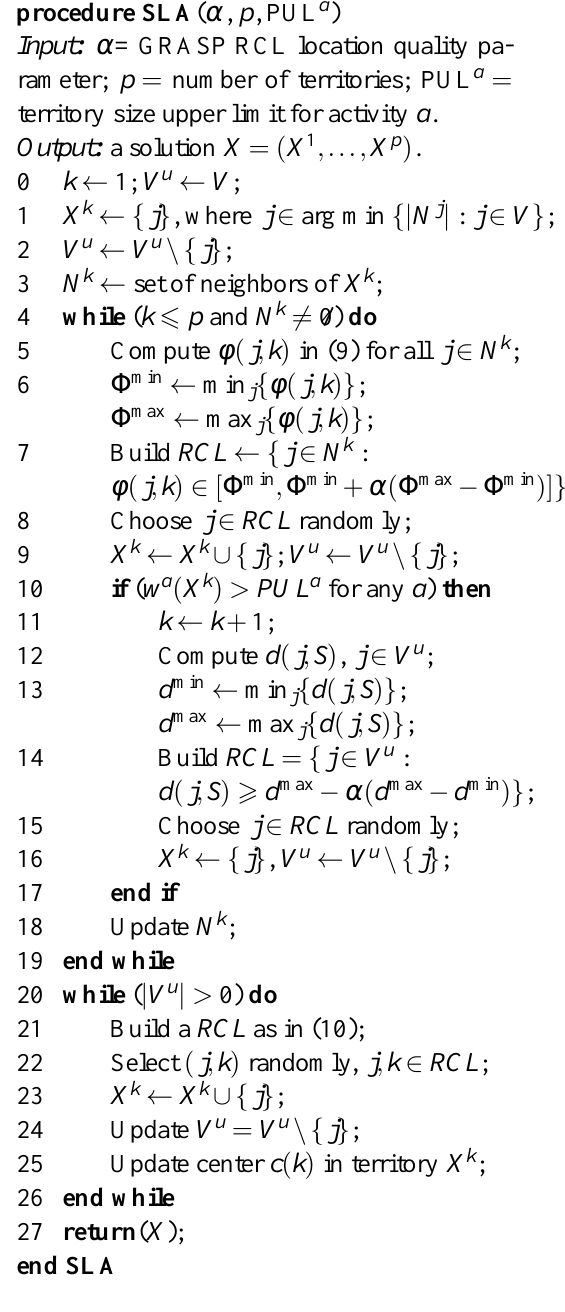
Fig. 6. Sequential location-allocation